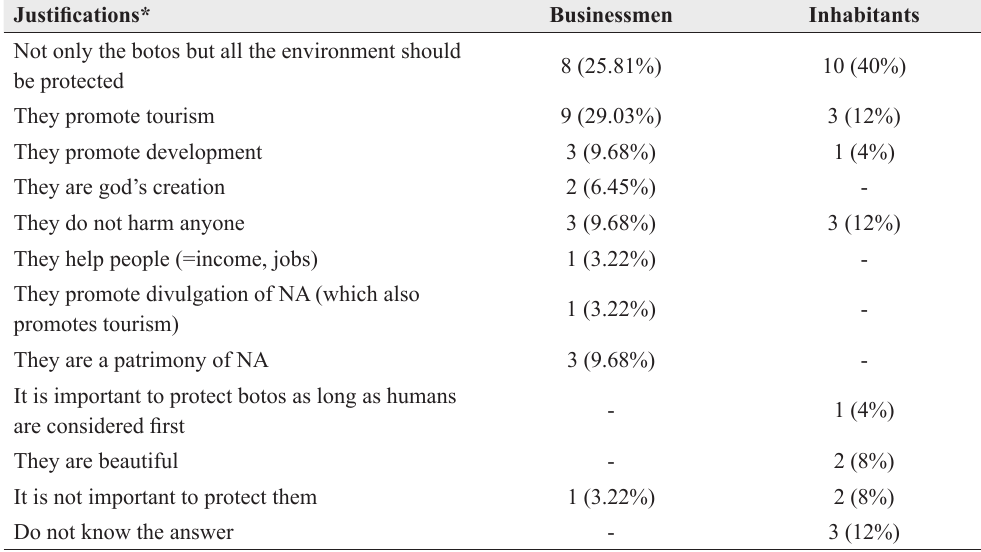
Justifications of the businessmen and inhabitants of Novo Airão for their perception about why the botos should be